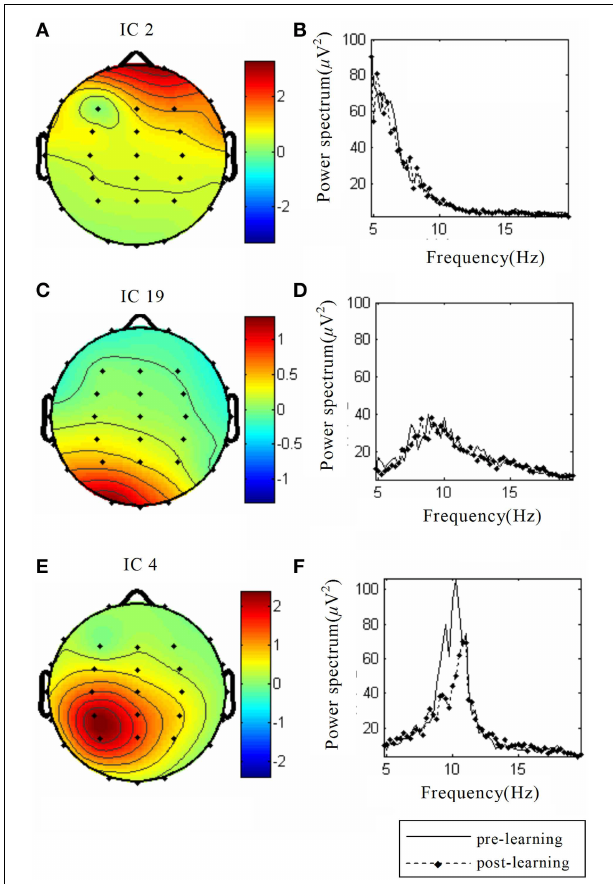
FIGURE 3 | The spatial distribution and the corresponding power spectrum diagram of three interested source signals. The source data come from simulation, including (A) Eye power signal IC2, (C) α rhythm source activity IC19, (E) Auditory stimuli evoked brain source activity IC4; (B) , (D), and (F) Power spectra of the above three source signals, respectively. The solid line indicates the pre-learning, and the dotted line indicates post-learning.